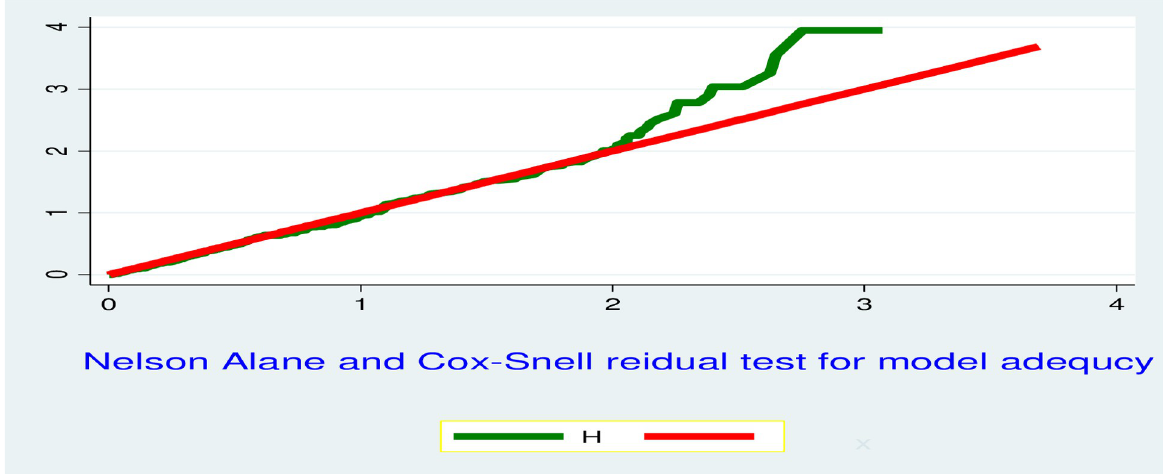
Fig 1. Final model adequacy graph based on Nelson Alan and Cox Snell residual test, 2020.